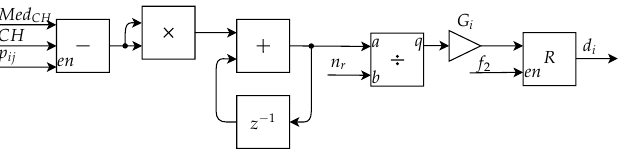
Figure 17. Architecture of variance.